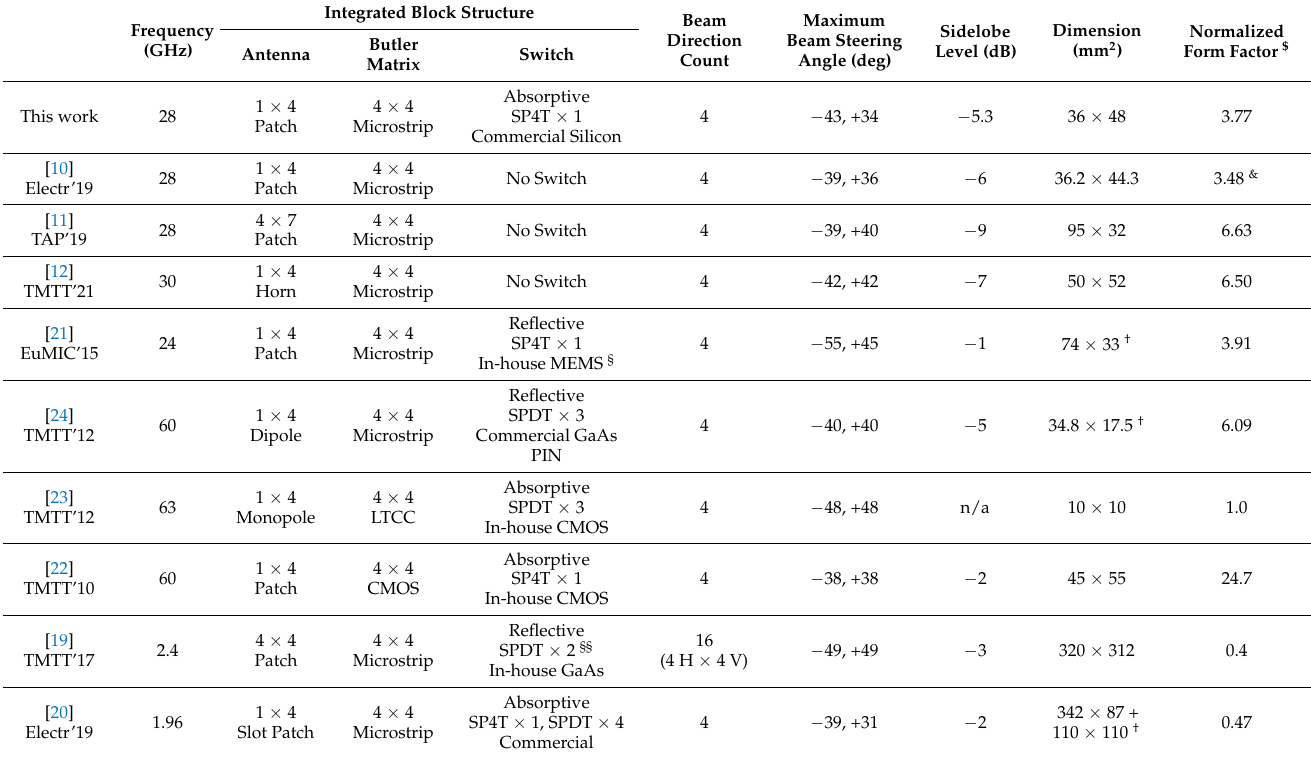
Table 2. Performance summary and